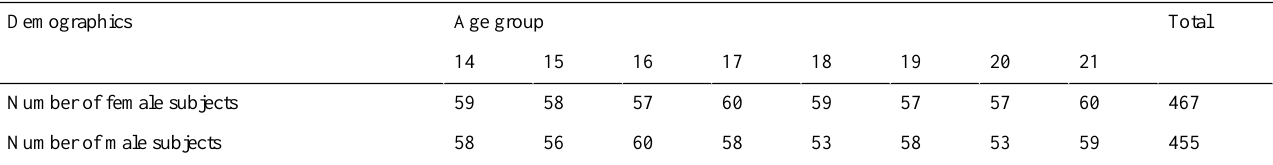
Table 1. Demographics of the final